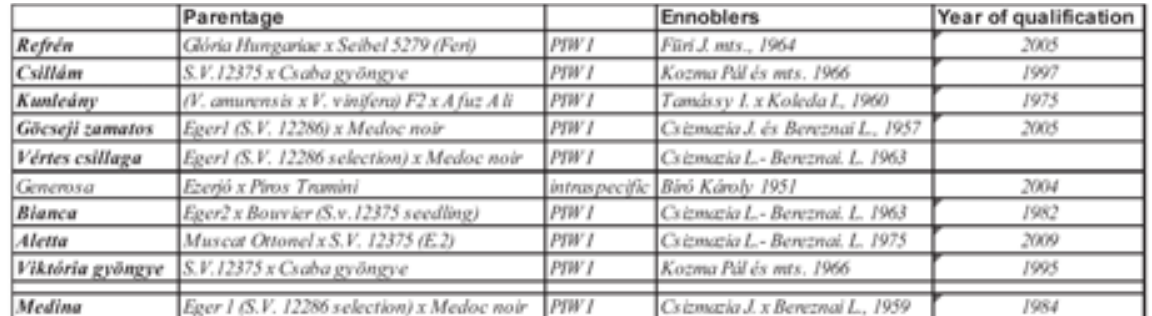
Table 1. Varieties in the trial (Csepregi-Zilai,